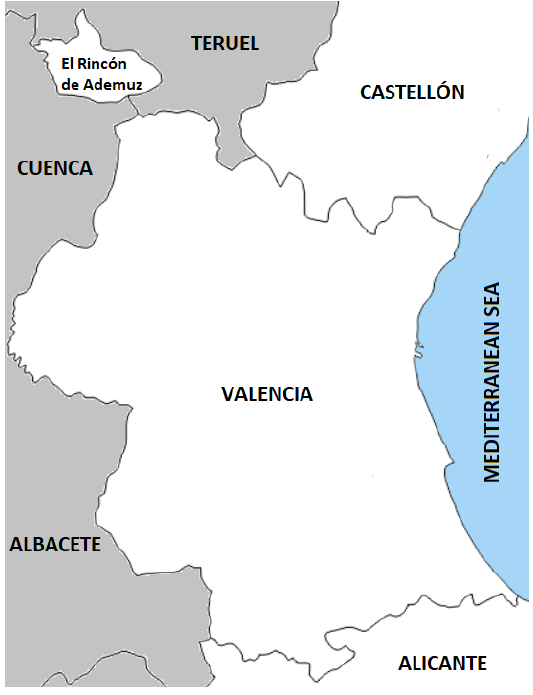
Figure 1. Shape of the province of